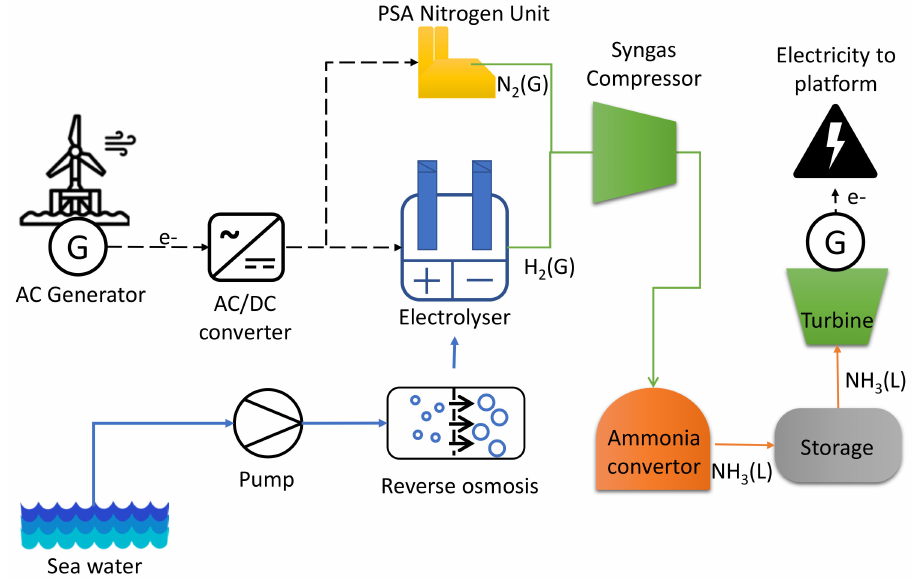
Figure 5. Ammonia value chain, including the main components in its production.